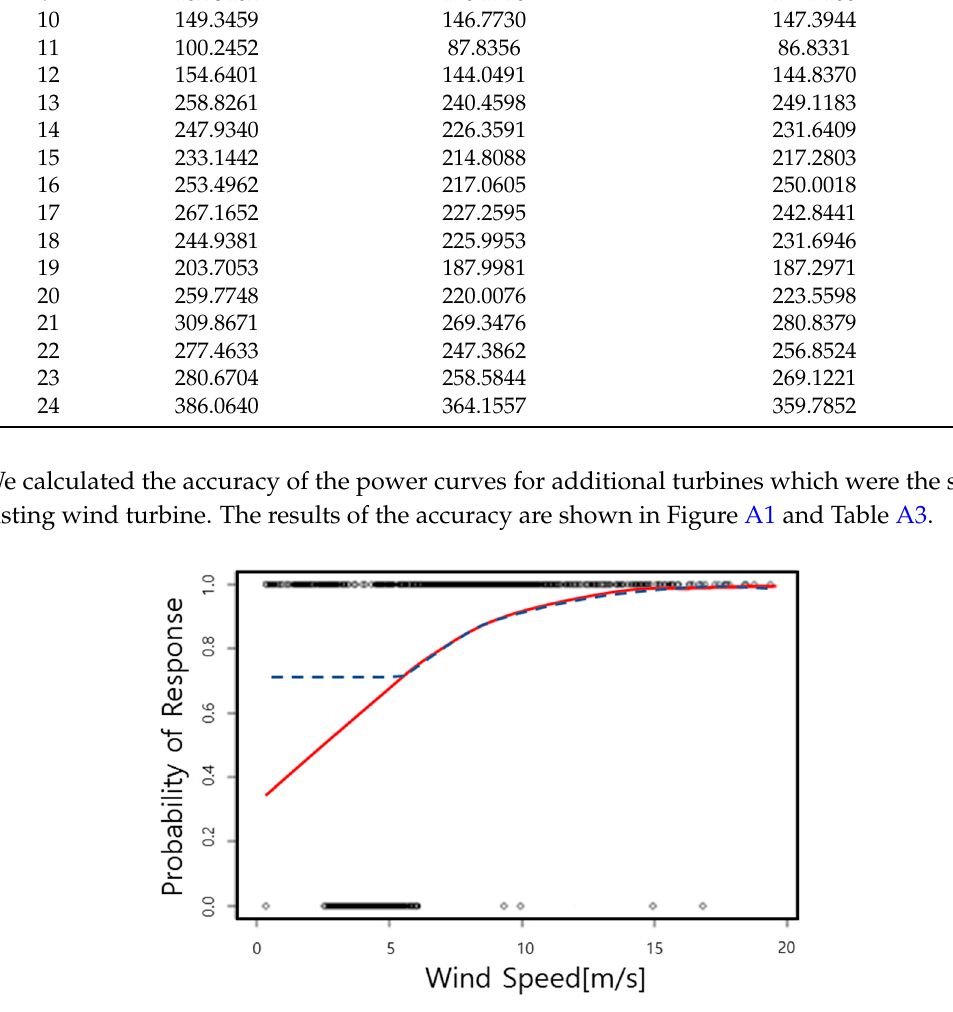
Figure A1. The statistical model for estimating accuracy of power curves for additional turbine using logistic regression (The red line is statistical model and the blue line is fixed minimum value).